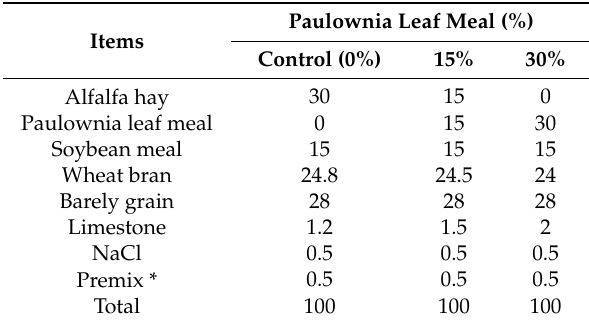
Table 1. Ingredients (percentage of the as-fed diet) of the growing rabbit diets.